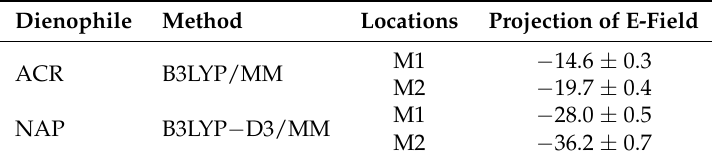
Table 2. The projections of electric fields on points M1 and M2, respectively, along unit vectors (cid:126) e 1 and − 4 a.u. where 1 a.u. = 51.42 V/Å) for the Diels–Alder reactions between cyclopentadiene and (cid:126) e 2 (in 10 acrylonitrile (ACR), 1-4-naphthoquinone